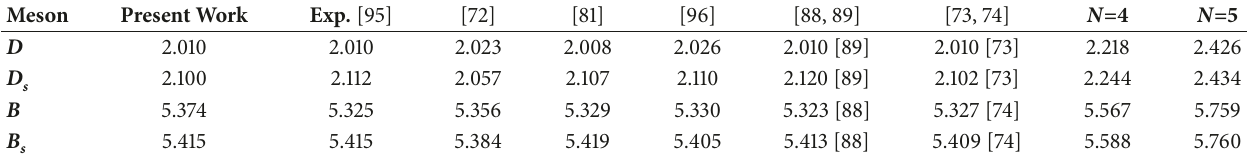
Table 3: Masses for vector ( 2𝑆+1 𝐿 𝐽 = 3 𝑆 1 ) mesons in GeV. 𝑎 = 0.026068 GeV 3 , 𝑏 = 0.218058 GeV 2 , and 𝑐 = 8 × 10 −3